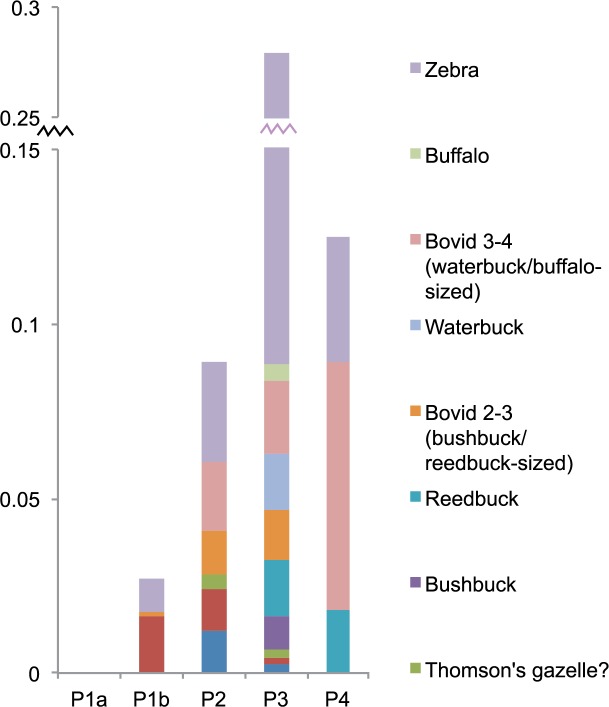
Extirpated bovids and equids in Kuumbi Cave Trench 10.Diachronic trends for extirpated bovids and equids only, with frequencies for these taxa expressed as a percentage of total NISP (number of identified specimens) for all fauna in each phase. For simplicity, tentative identifications to taxon were treated as if they were positive; for example, Cf. T. scriptus and T. scriptus are both listed here as bushbuck. For detailed data, see S1 Table.